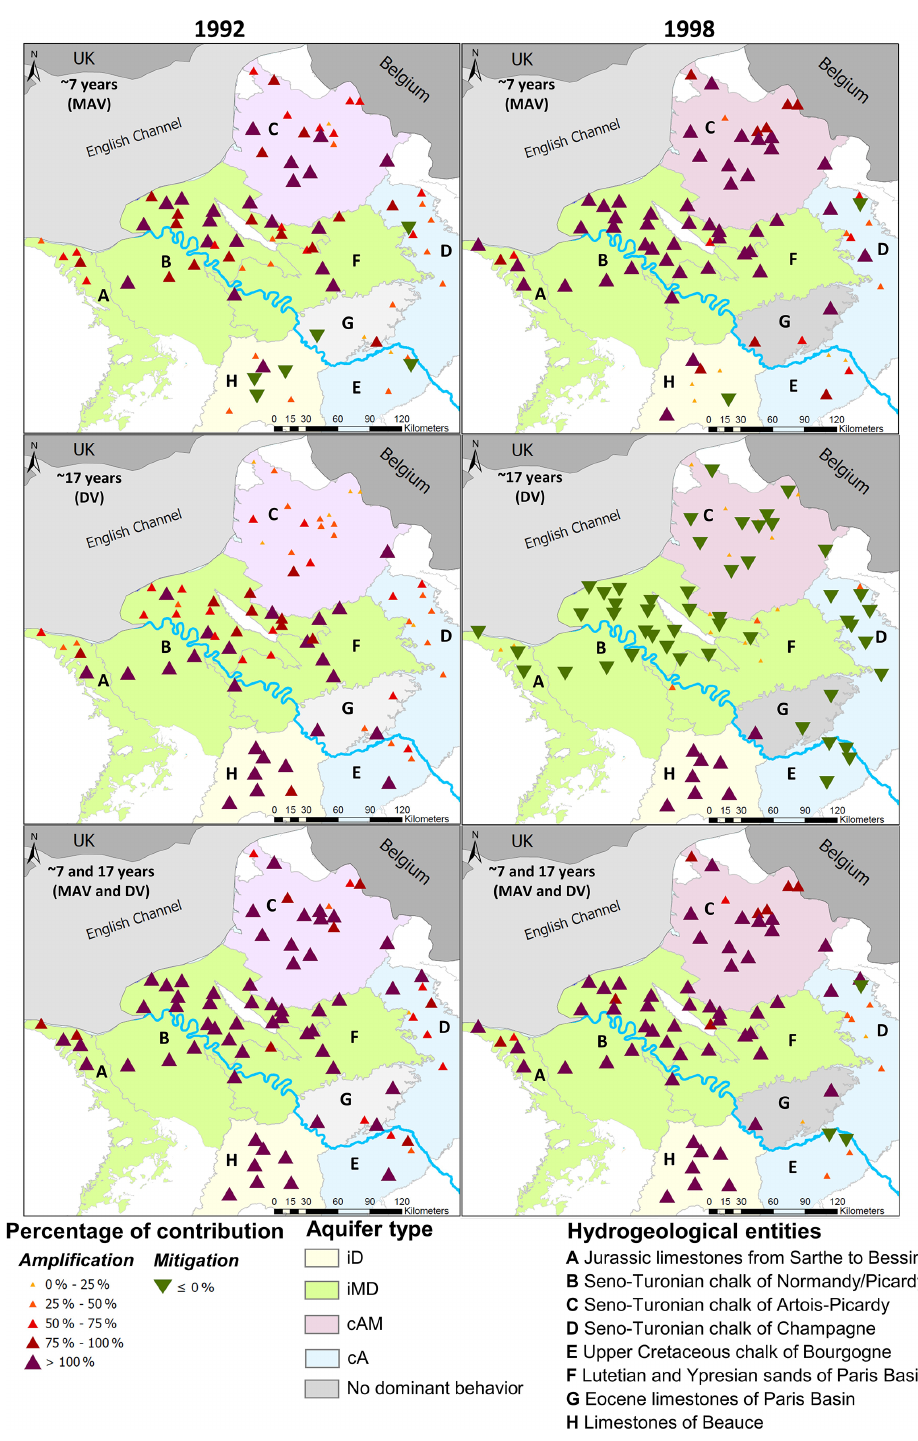
Figure 13. Contribution of ∼ 7-year (MAV), ∼ 17-year (DV), and ∼ 7- and ∼ 17-year components in the amplitude of threshold ex- ceedance (ATE): case of 1992 and 1998 low levels (percentile 0.2). It indicates if the component generates (contribution to ATE ≥ 100%), attenuates (contribution to ATE < 0%), or amplifies (contribution in ATE between 0% and 100%) the low level. In the case of missing borehole(s) on maps, it means that either the 1992 or 1998 low level was not identified in the time series (i.e. no threshold exceedance).